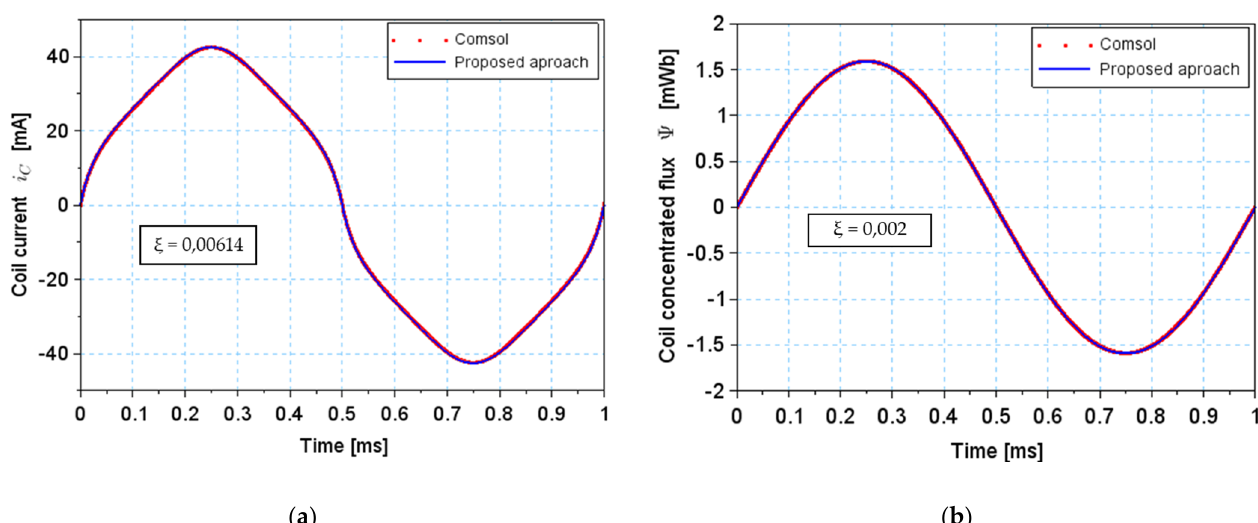
Figure 19. ( a ) Inductor current i c waveforms for the case of a sinusoidal voltage source and frequency of 1 kHz. ( b ) Flux linkage Ψ waveform for the case with a sinusoidal voltage source and frequency of 1 kHz.